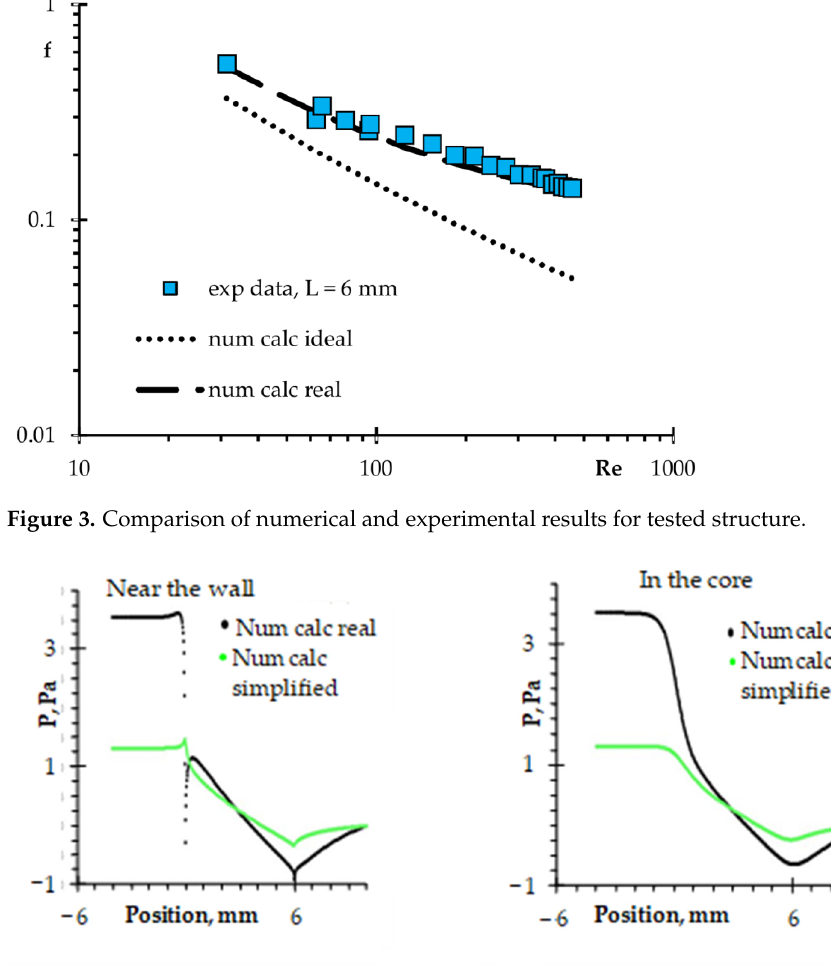
Figure 4. Comparison of static pressure along the computational domain between simplified and real models ( u 0 = 1 m ∙ s − 1 ): ( a ) near the wall; ( b ) in the core.